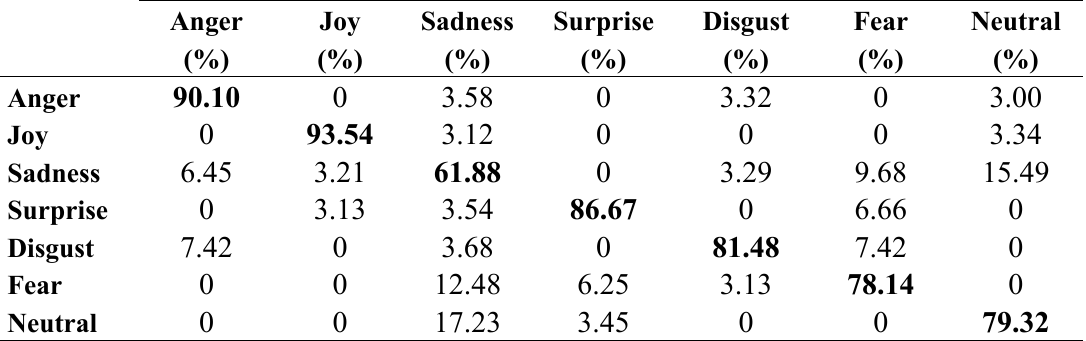
Table 2. Confusion matrix of 7-class facial expression recognition results obtained by KDIsomap on the JAFFE database.